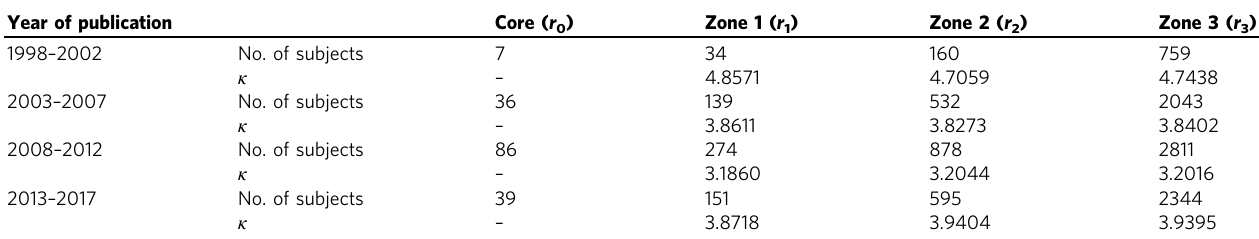
Table 6 Bradford ’ s constant ( κ ) for each Bradford ’ s and time